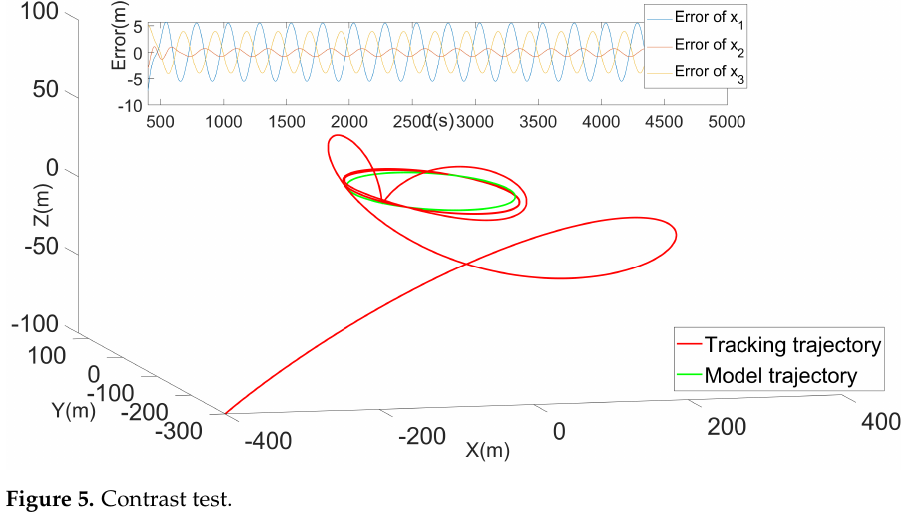
Figure 5. Contrast test.